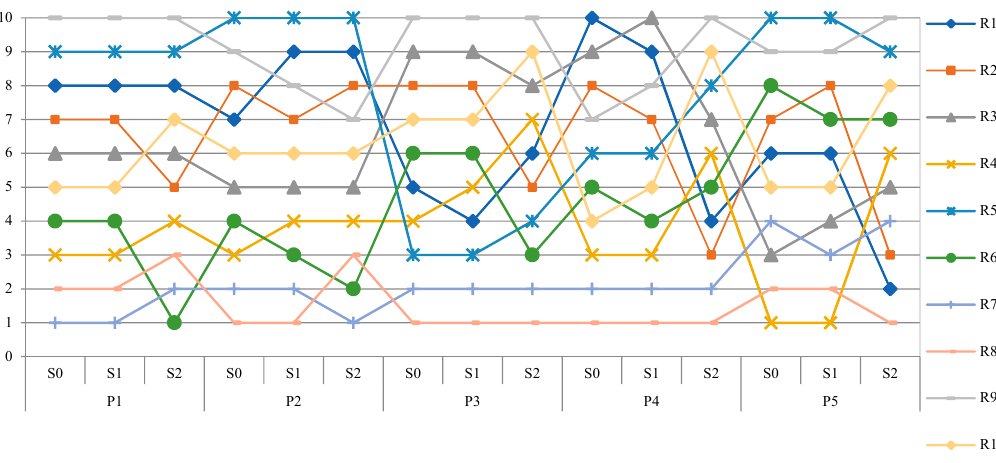
Figure 8. Risks ranking with respect to the considered Statuses .